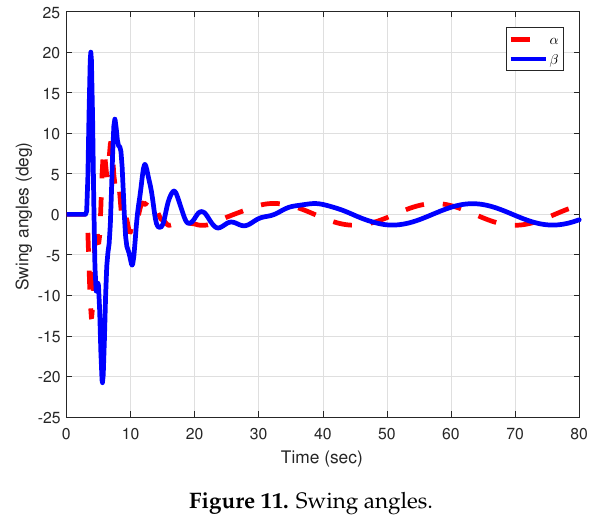
Figure 11. Swing angles.